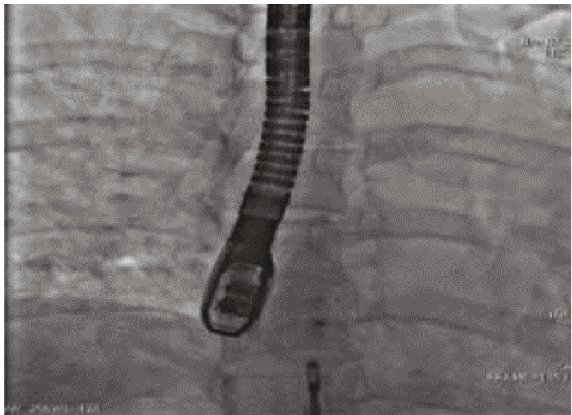
Figure 4: Percutaneous PFO closure with a Figulla Flex II PFO occluder. Left side portion of the device opened in the left right